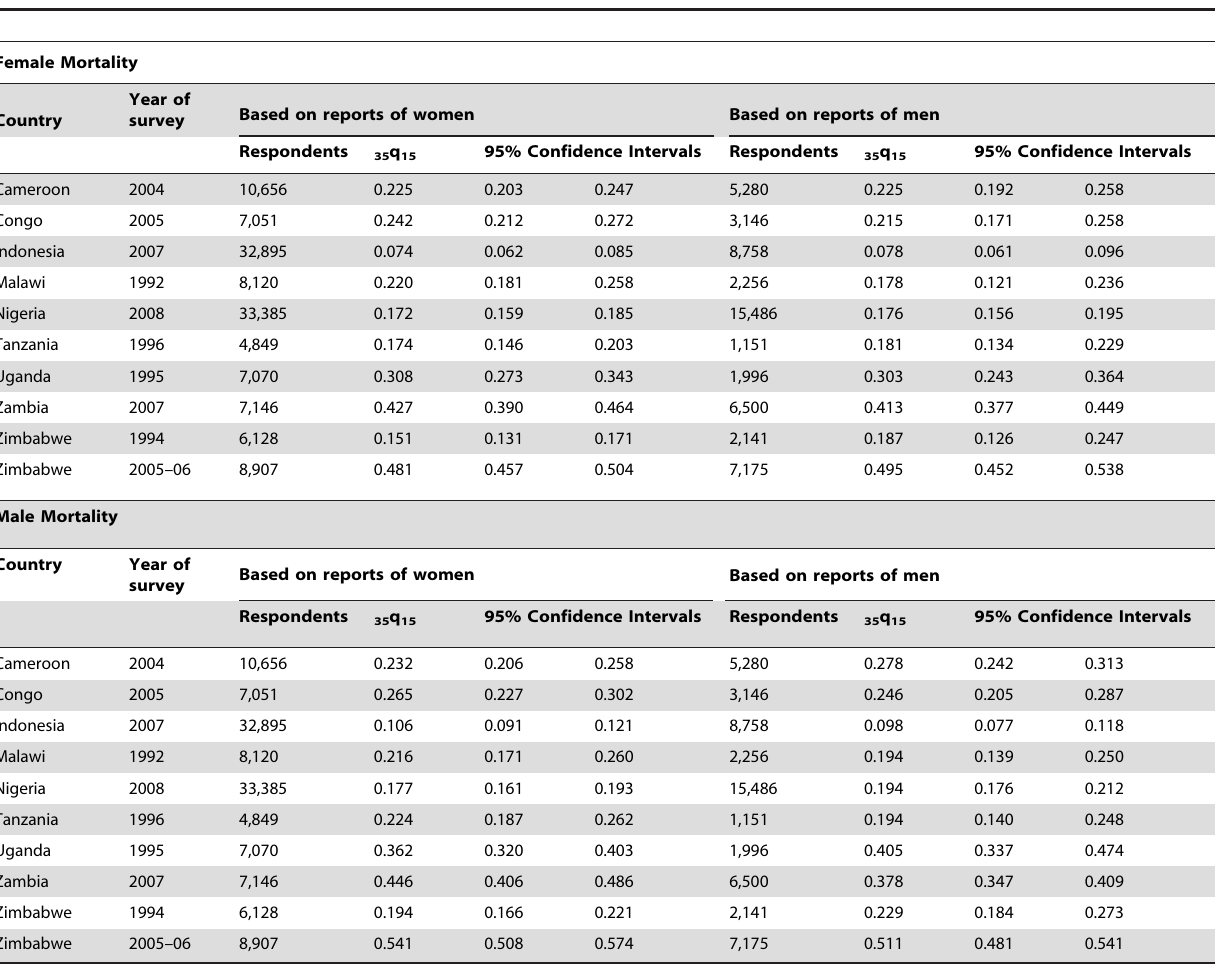
Table 1. Female and male probabilities of dying ( 35 q 15 ) for the 1–5 calendar years preceding the survey obtained from sibling histories reported by women and